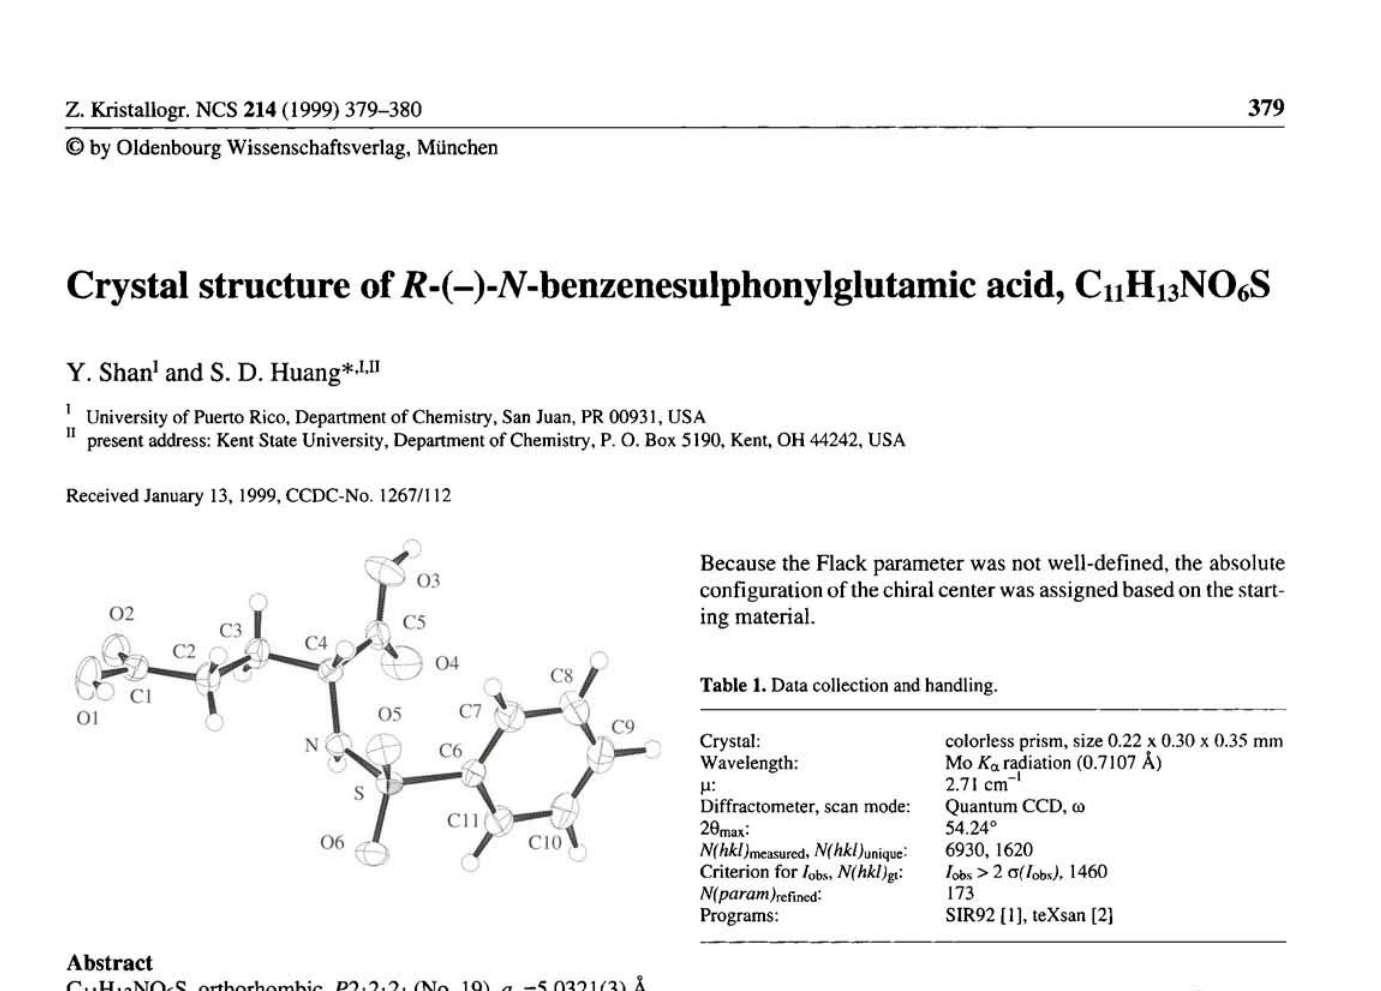
Table 2. Atomic coordinates and displacement parameters (in Â 2